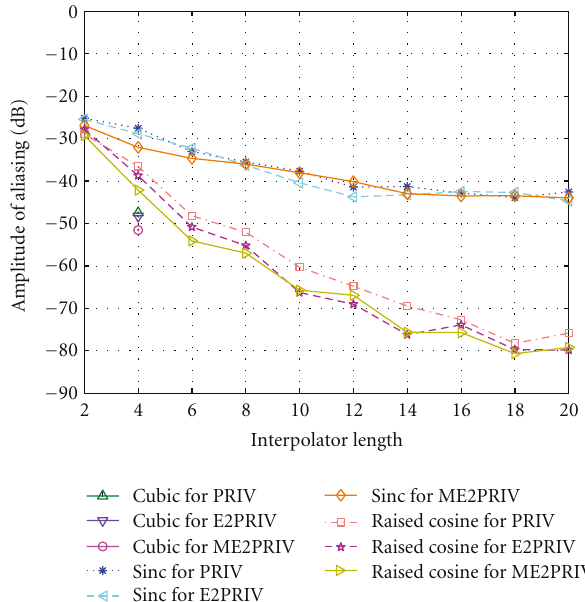
Figure 4: Peak amplitude of aliasing versus truncation length for PRML